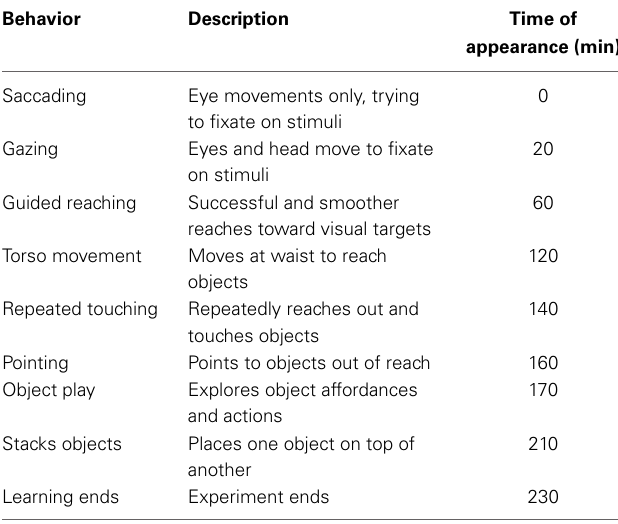
Table 6 | Behaviors observed on the iCub.